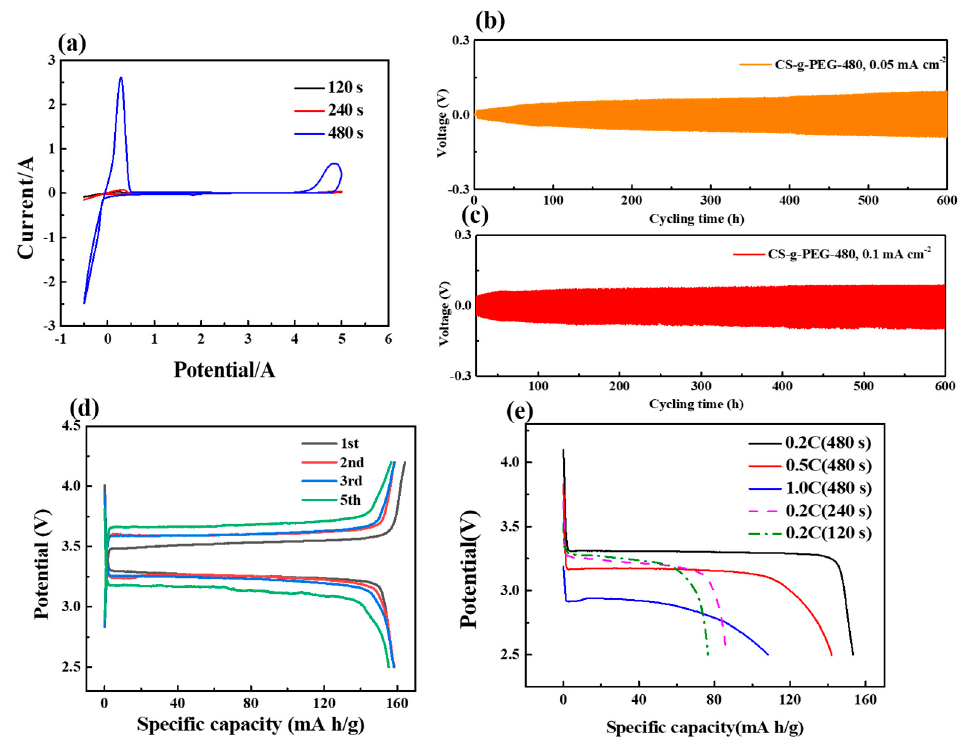
Figure 9. Electrochemical performance of CS-g-PEG GPEs. ( a ) CV curves of stainless steel (SS)/CS- g-PEG GPEs/Li cells. ( b ) Voltage profiles of Li/CS-g-PEG-480/Li cells at transfer charges of 0.2 mA•h cm − 2 , 0.05 mA cm − 2 and ( c ) 0.1 mA cm − 2 current densities. ( d ) Charge–discharge profiles of LiFePO 4 /Li battery using CS-g-PEG-480 at 0.2 C for different cycles. ( e ) The initial discharge profiles of LiFePO 4 /Li battery using CS-g-PEG-120, 240 and 480.